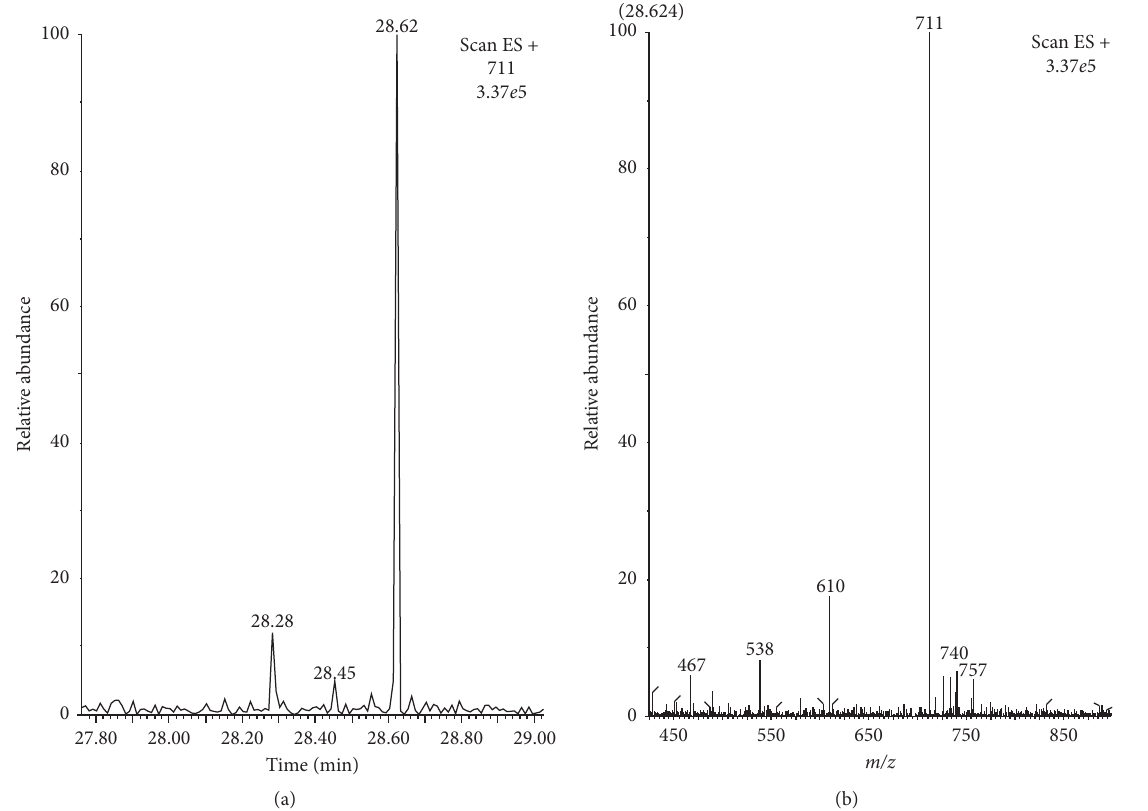
Figure 5: Extracted ion chromatogram (a) and the corresponding mass spectrum (b) based on the molecular ion at m / z 711 that could arise from dicarbinolamine 12 .